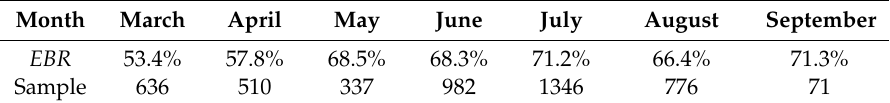
Figure 2. ( a ) Mean daily variations in the energy closure from 5 January to 31 December 2010. ( b ) Same as ( a ) but corrected for the soil heat flux. ( c ) Mean daily variations in the flux ( H is the surface sensible heat flux, LE is the latent heat flux, R n is the net radiation, and G 0 is the surface soil heat flux). ( d ) Same as ( c ) but corrected for the soil heat flux. ( e ) Scatter plot with regression for H + LE and R n − G 2.5 . ( f ) Scatter plot with regression for H + LE and R n − G 0 . ( g ) Mean daily variations in the soil heat flux at depths of 2.5 cm and 8 cm. ( h ) Mean daily variations in the friction velocity and Bowen ratio. Table 3. EBR in every